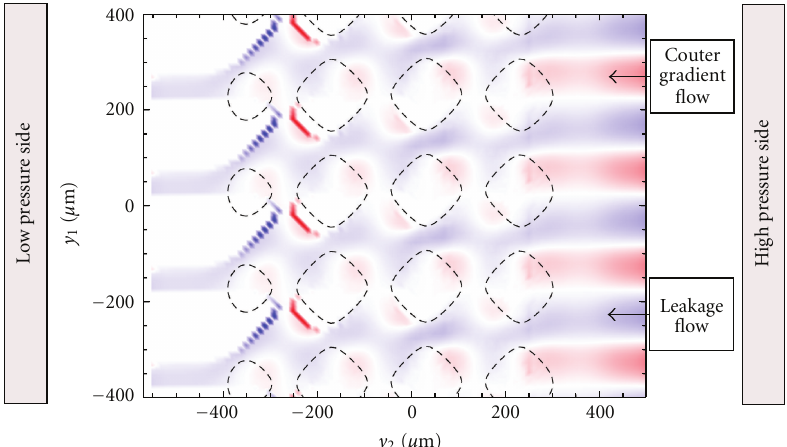
Figure 12: Axial average flows. Red areas correspond to the counter-gradient flows (i.e., directed from left to right). For (cid:22) U = 800.